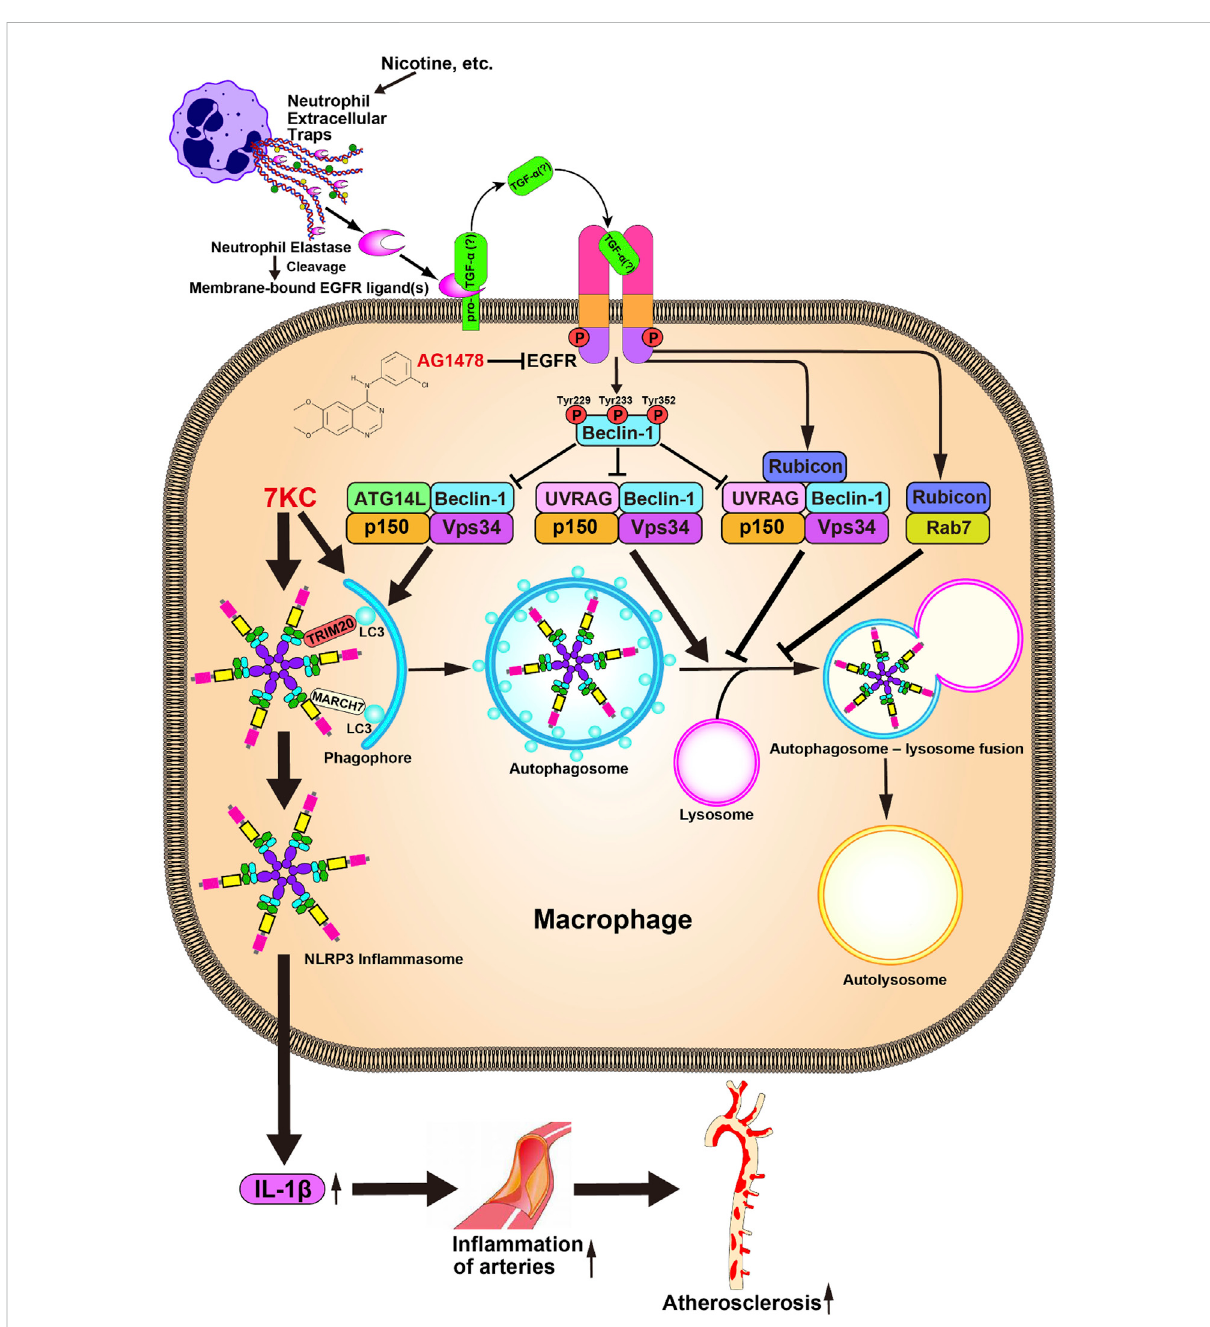
FIGURE 6 Proposed model for the deterioration of atherosclerosis by NETs. NETs induced by the various stimuli, including the nicotine, promote EGFR activitypossiblythroughfacilitatingconversionofamembrane-boundEGFRligandsuchasTGF- α ,toitsactivesolubleformbyitsproteolyticactivity. Activated EGFR phosphorylates Beclin-1, thereby suppressing the Beclin-1-dependent PI3 kinase activity, which results in the suppression of an autophagy machinery. Attenuation of the autophagy activity causes enhancement of the in fl ammasome activity, which results in the aggravation of the